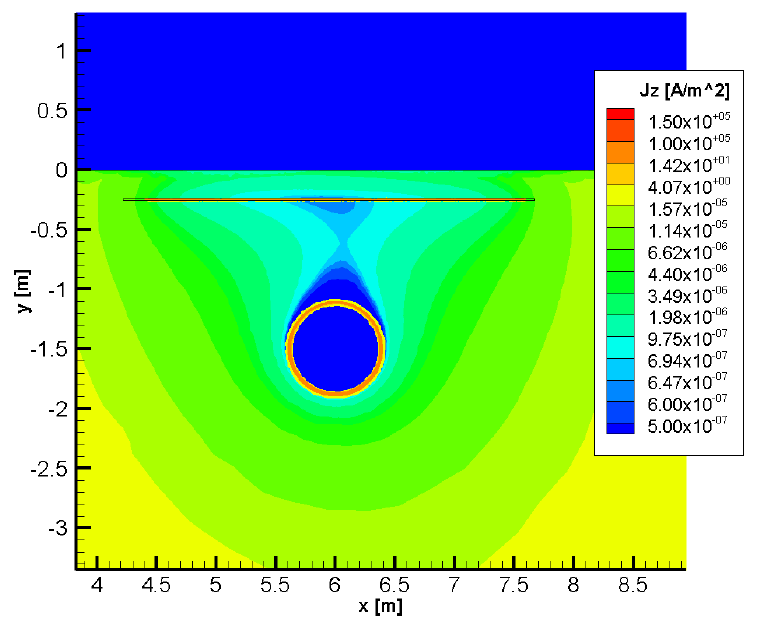
Figure 8. Current density magnitude distribution yielded by the FEM analysis when a single conductive sheet is buried above the